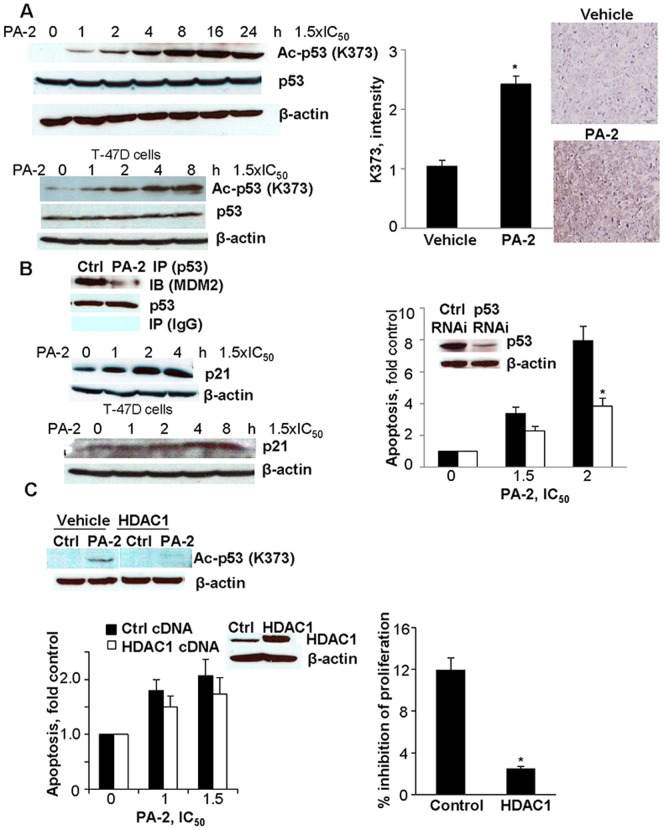
Phospho-aspirin-2 acetylates p53.
A:
Left: PA-2 induced the acetylation of p53 in MCF7 or T-47D cells (K373) in a time-dependent manner. Right: PA-2 induced p53 acetylation in MCF7 xenograft (K373). Representative images (right) and the quantification (left) of acetylated p53 (K373) positive cells in tumor sections, * p<0.001. B:
Left: The effect of PA-2 on p53-MDM2 interaction as determined by immuno-precipitation (top) and the expression of p21 by western blot (bottom). Right: siRNA-mediated knockdown of p53 attenuated the pro-apoptotic effect of PA-2 in MCF7 cells (results are the average of three independent experiments, *p<0.05). Knockdown of p53 was determined by western blot. C: HDAC1 overexpression suppressed the anticancer activity of PA-2. Left: HDAC1 overexpression abrogated PA-2-induced the acetylation of p53 at K373 (top) and mildly suppressed its ability to induce apoptosis in MCF7 cells (bottom, results are the average of three independent experiments, *p<0.05). Right: HDAC1 overexpression suppressed the effect of PA-2 on cell proliferation in MCF7 cells (results are the average of three independent experiments, *p<0.05).